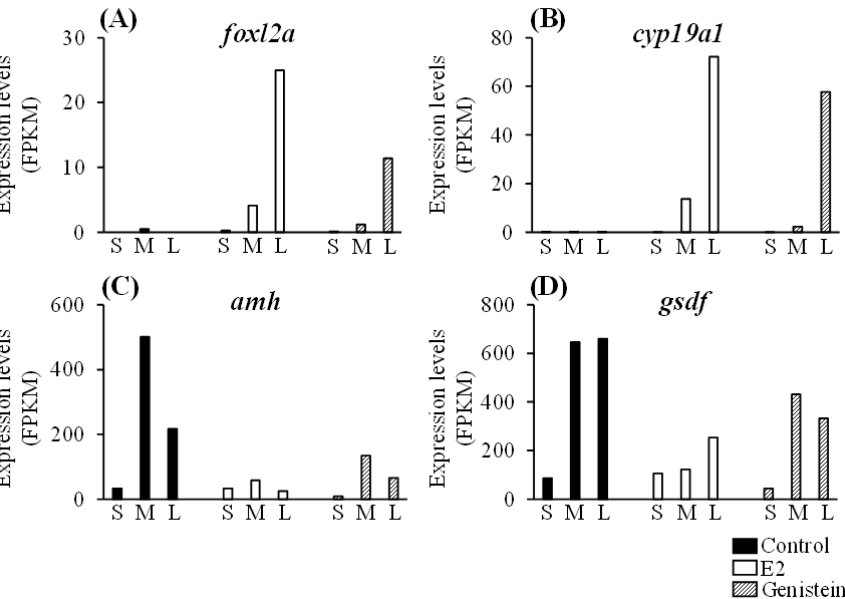
Figure 6. FPKM values of sex-specific genes in the gonads of Japanese eels. ( A , B ) Female-specific genes. ( C , D ) Male-specific genes. S, small (body length <15.0 cm); M, medium (body length